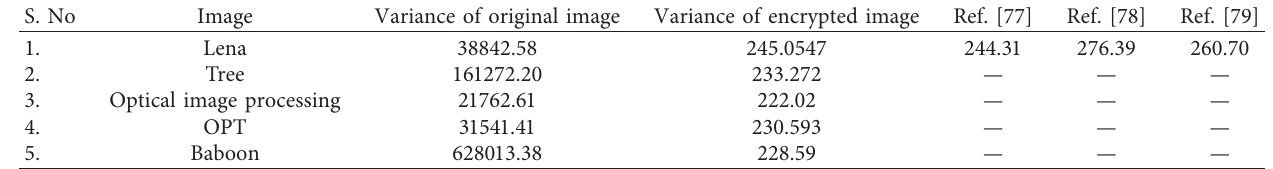
Table 3: Histogram variance results of 5 images using the proposed cryptosystem.